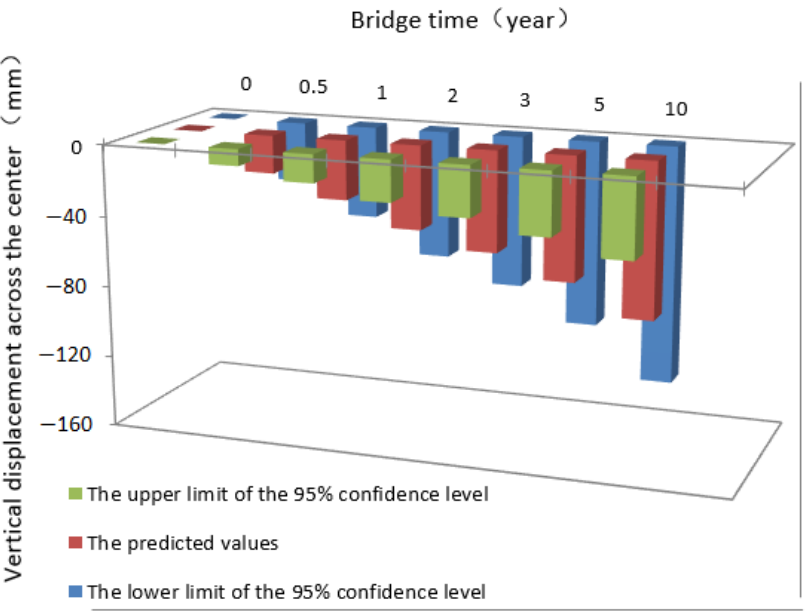
Figure 8. Vertical deformation predicted interval at different confidence levels.